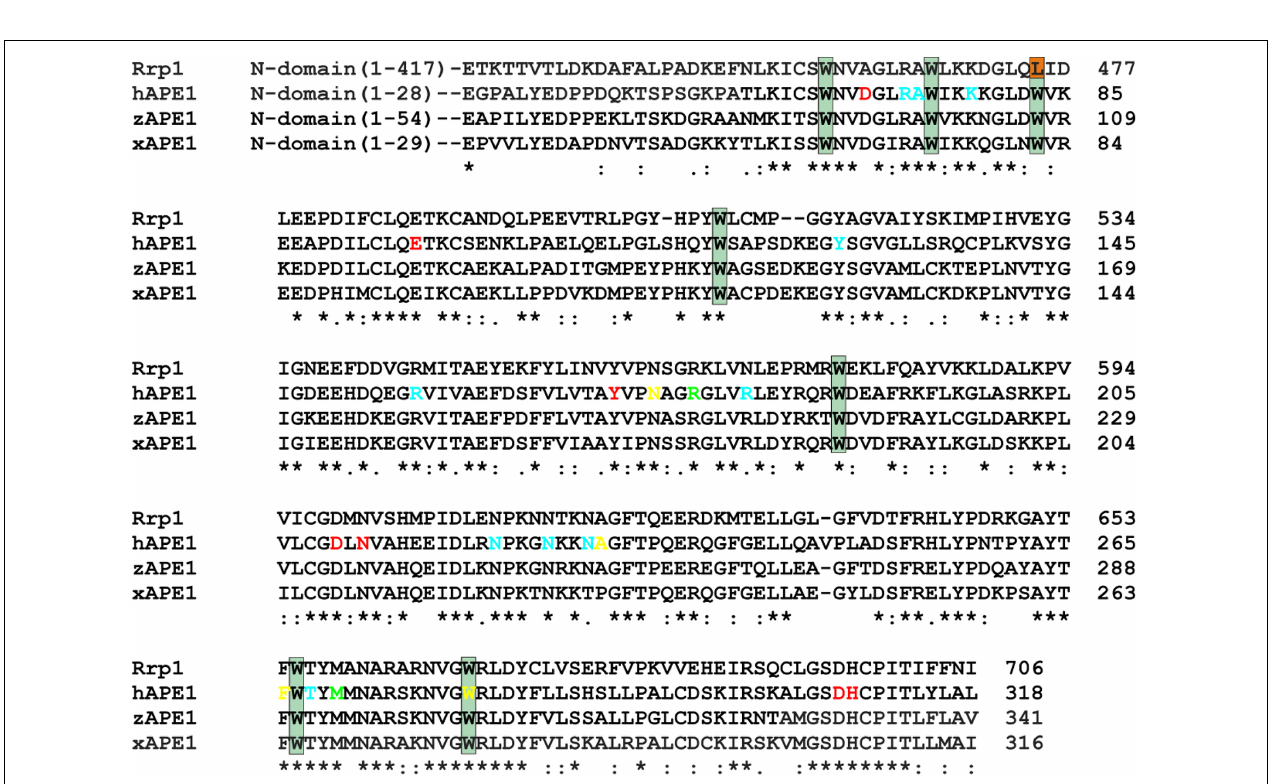
FIGURE 2 | An alignment of sequences of hAPE1, xAPE1, zAPE1, and Rrp1. Catalytic amino acid residues Asp70, Glu96, Tyr171, Asp210, Asn212, Asp308, and His309 (red); amino acid residues of the DNA-binding site Arg73, Ala74, Lys78, Tyr128, Arg156, Arg181, Asn222, Asn226, Asn229, and Thr268 (blue); intercalating amino acid residues Met270 and Arg177 (light green); and residues Asn174, Asn229, Ala230, Phe266, and Trp280 forming the damaged base-binding pocket (yellow) are highlighted. Conserved Trp residues are indicated by dark green boxes. Asterisks indicate identical residues, colons denote conserved residues, and dots are residues with at least some physicochemical properties